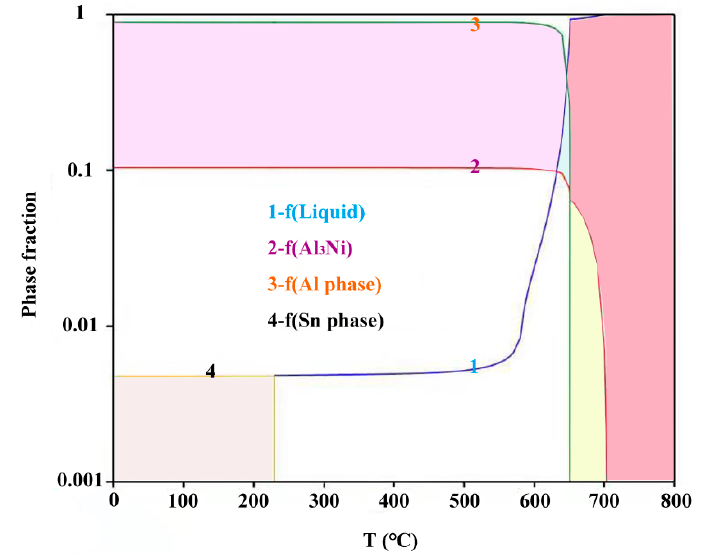
Figure 3. The phase calculation under ambient pressure using the Pandat software.